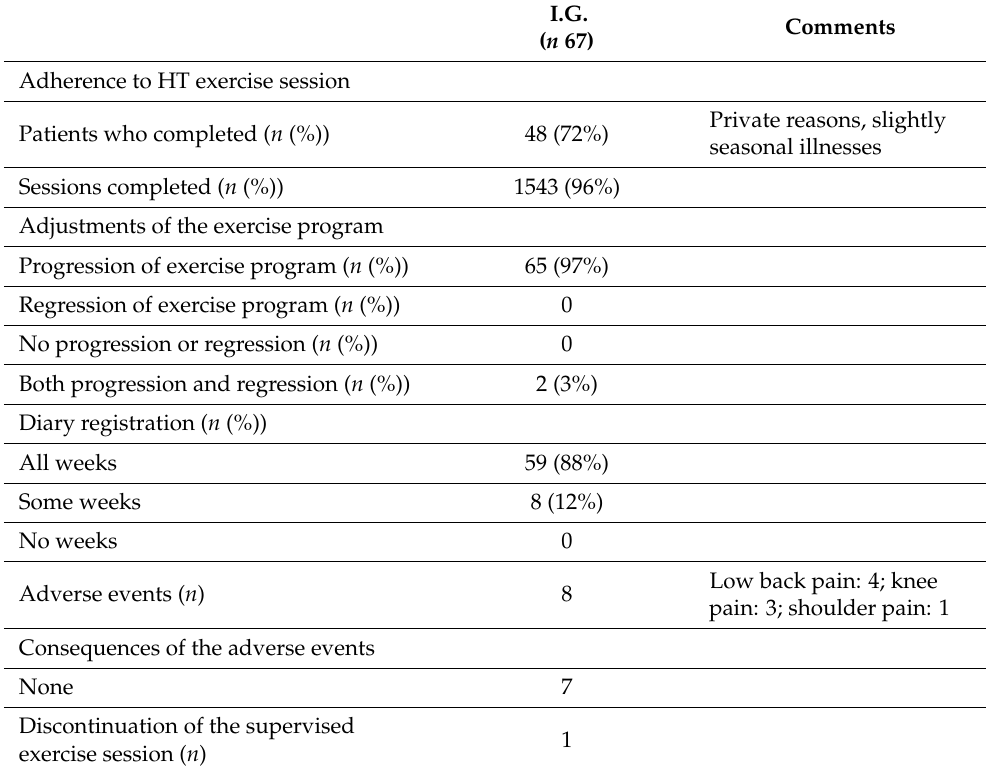
Table 2. Home training feasibility. I.G. is the initial group number.